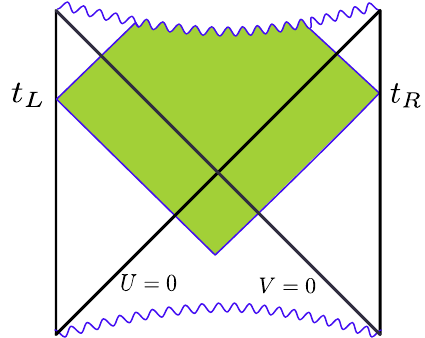
Fig. 17 The Wheeler–DeWitt patch used in the computation of CA